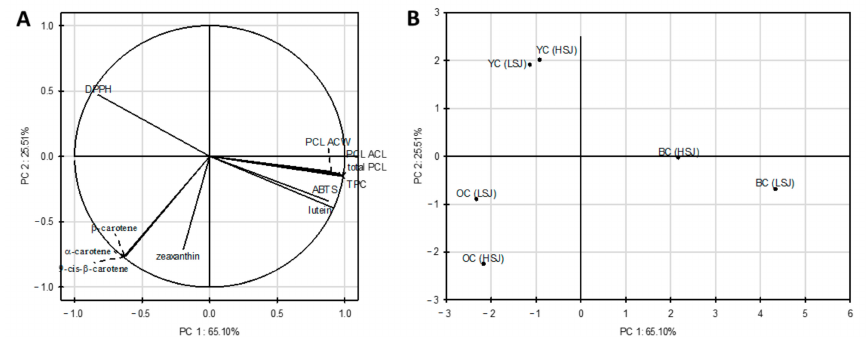
Figure 3. Principal components plot, variations in the parameters (ABTS, DPPH, PCL ACW, PCLACL assays and sum of the PCL) of the analyzed carrot juices ( A ) score plot of the obtained juices ( B